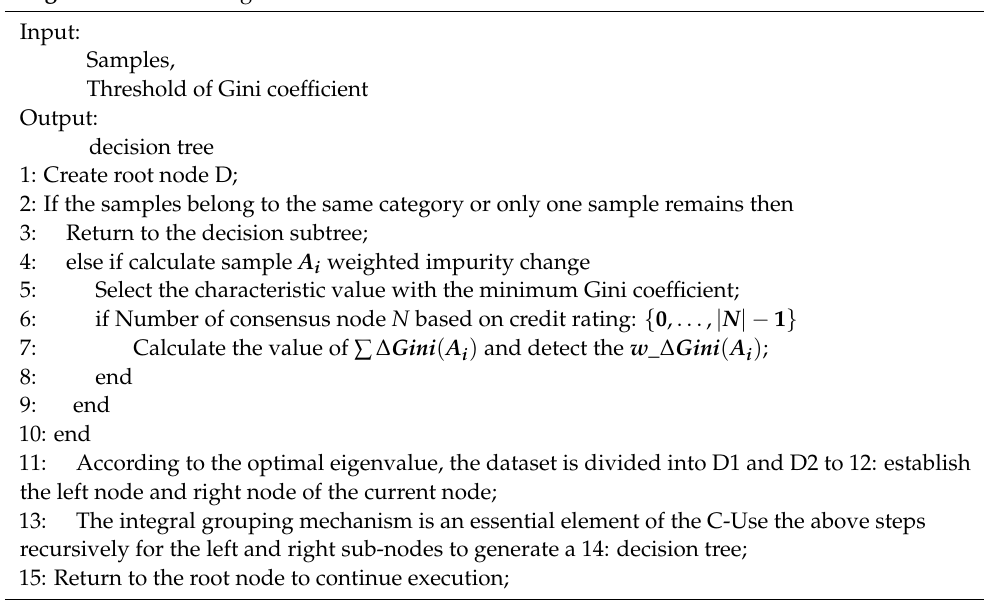
Algorithm 1 CART